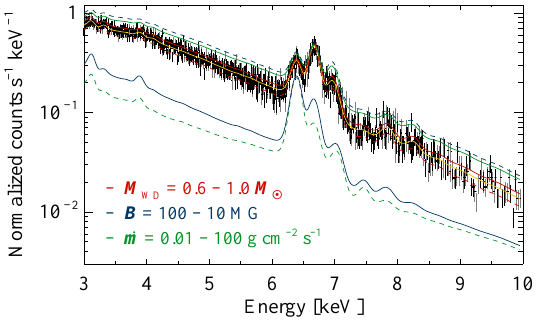
Figure 5: Simulated 50 ks eROSITA observation of a polar at ˙ m = 1 . 0 g cm − 2 s − 1 , B = 30 MG, M WD = 0 . 8 M (cid:12) , scaled to the XMM-Newton spectrum of AM Her (black: data, yellow: model). Each colored line represents one parameter that is varied while the other parameters and the reflection component are fixed (dashed: lowest, solid: highest